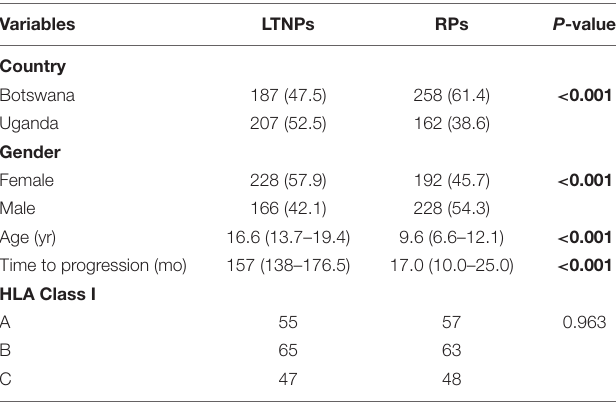
TABLE 1 | Baseline characteristics among LTNPs and RPs.